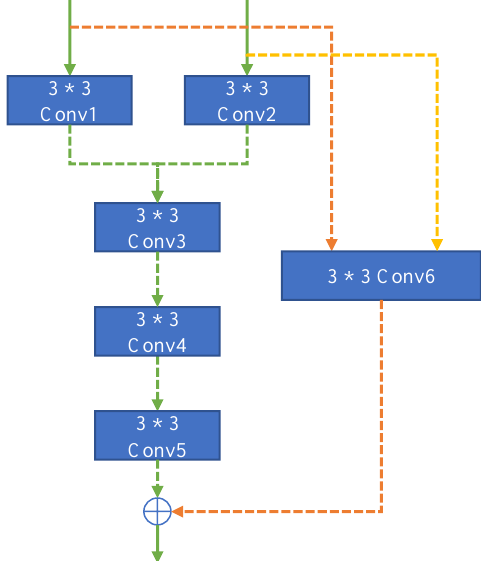
Figure 5. The network structure of CFN.